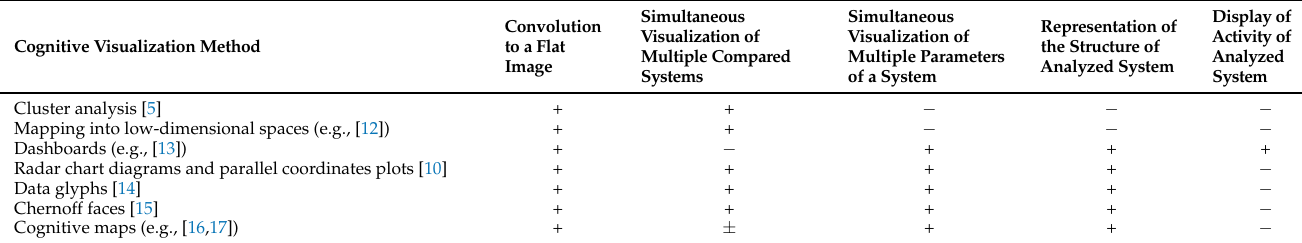
Table 1. Comparison of approaches to visualizing multiparameter systems.